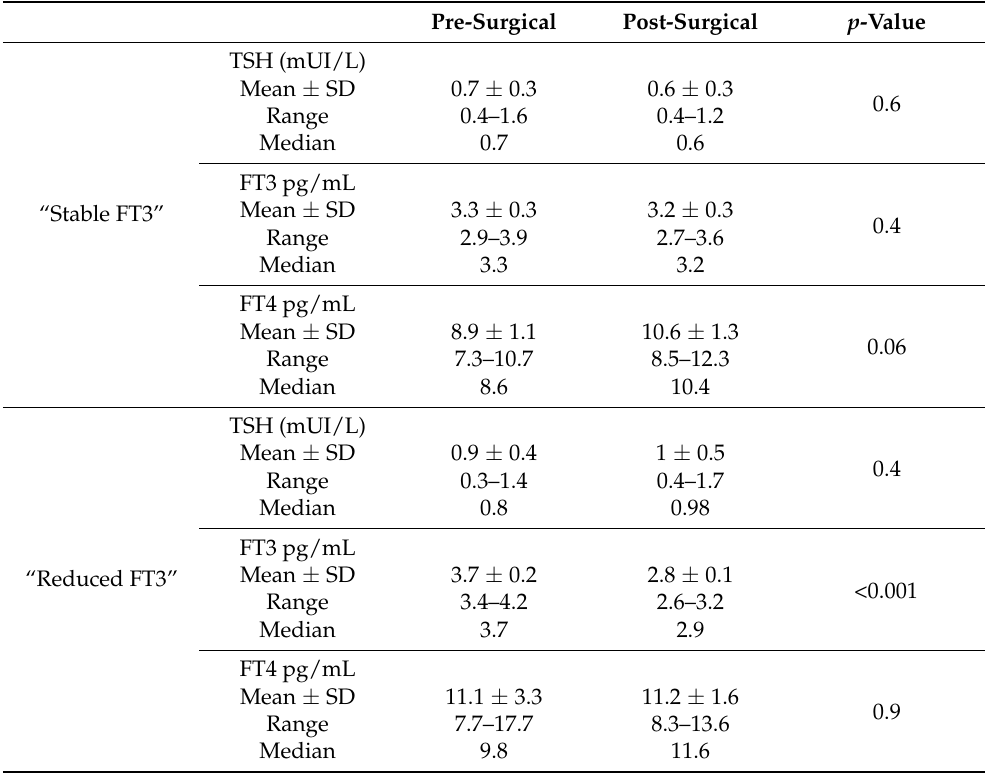
Table 2. Pre- and post-surgical biochemical data according to the two subgroups: “stable FT3” and “reduced